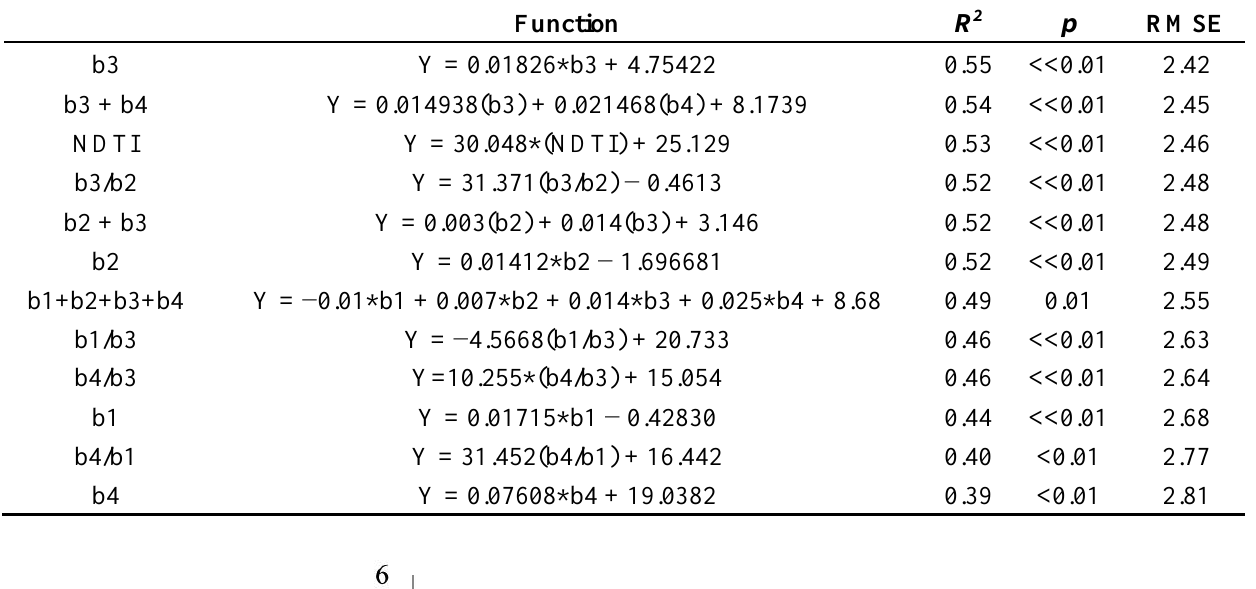
Figure 3. A strong correlation (r 2 = 0.55) exists between turbidity measured in the field (NTU C ) and NTU values estimated remotely. Table 1. Relations between NTU C and Landsat bands or band combinations. Turbidity data acquired in August 2009. Table ordered from highest to lowest R 2 .